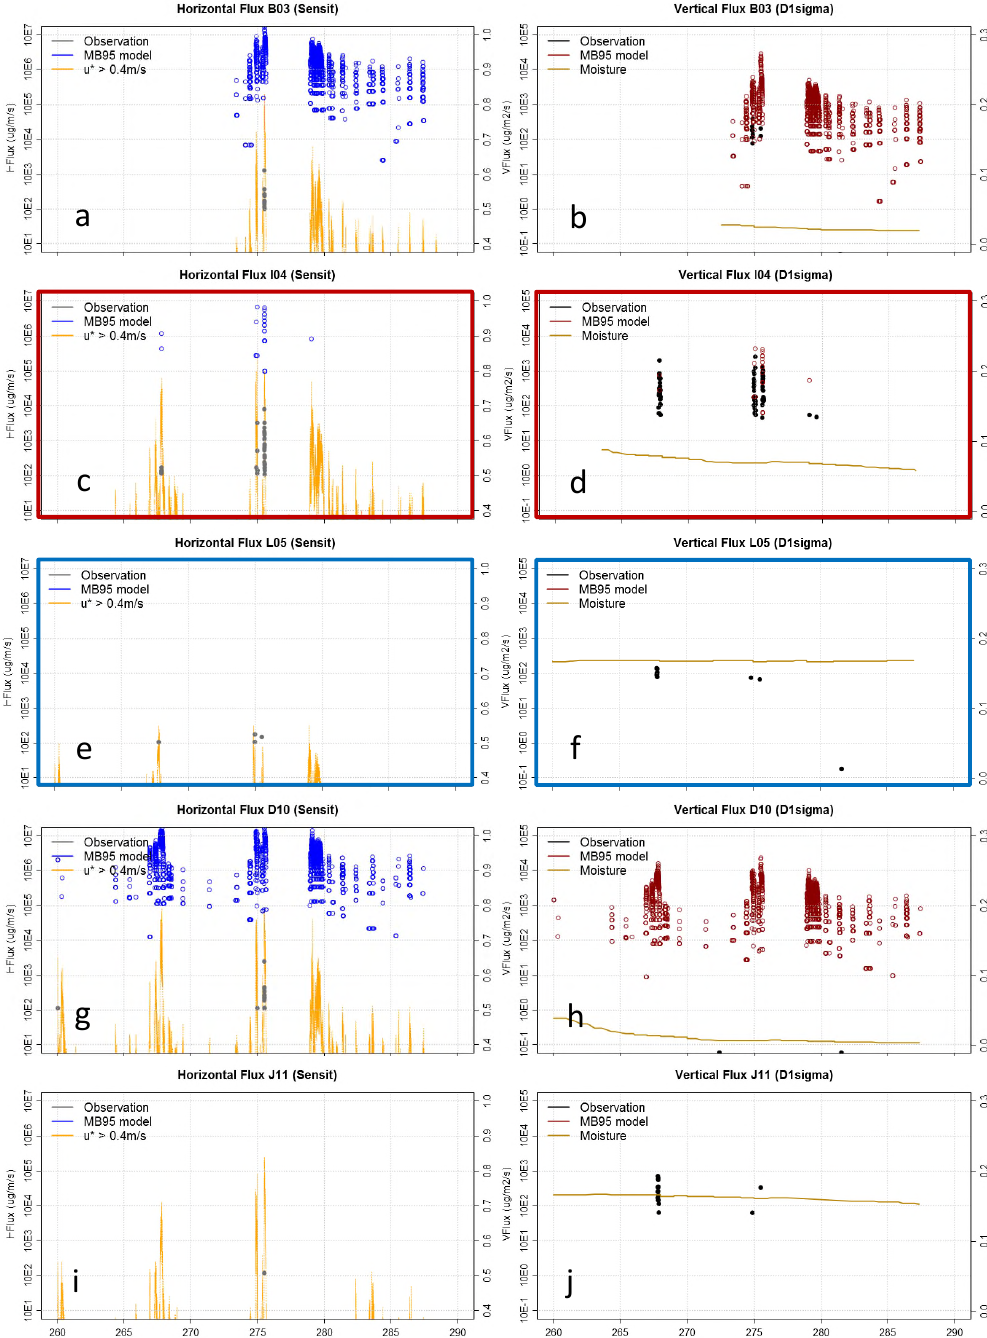
Figure 2. Horizontal and vertical flux for Exp. 1a (MB95 scheme) at five field sites: B3 (a, b) , I4 (c, d) , L5 (e, f) , D10 (g, h) , and J11 (i, j) . The observed (modelled) saltation and vertical fluxes are shown in grey (blue) and black (dark red) dots. The period between DOY 260 (17 September) and DOY 290 (17 October 2011) is shown. The box model is driven with observed u ∗ values. On the left-hand side, the shear velocity is shown (orange; values on the right ordinate). On the right-hand side, the soil moisture content below 0.3m 3 m − 3 is shown (dark yellow; values on the right ordinate). Site I4 is referred to as a dusty site (c, d) . Site L5 emitted least throughout the 2011 campaign (e, f) . I4 and L5 are marked with red and blue borders throughout the